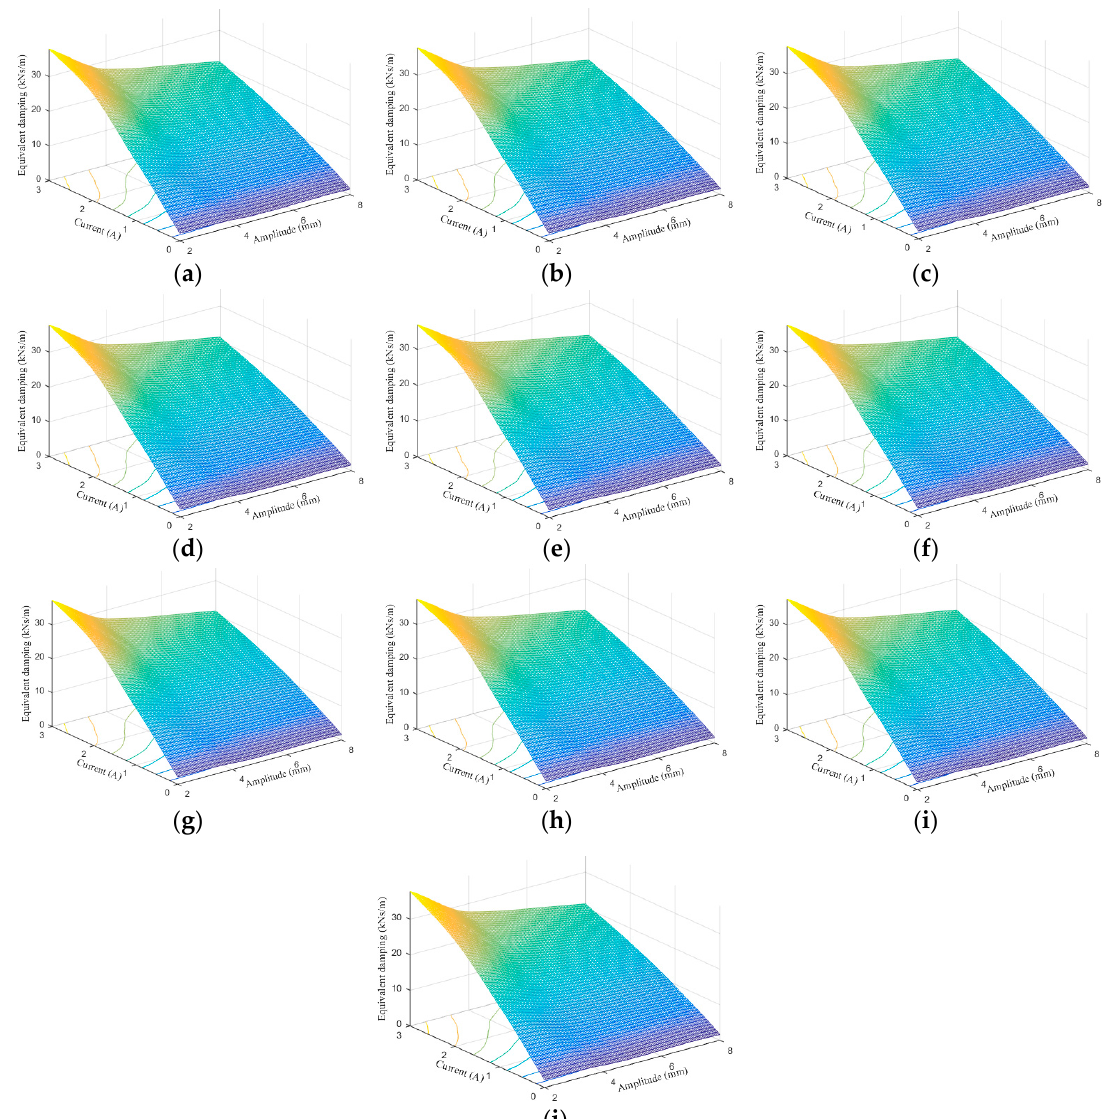
Figure 26. Effective stiffness estimation results of 4 Hz loading frequency. ( a ) Experimental measurement, ( b ) Kelvin–Voigt model, ( c ) four-parameter viscoelastic model, ( d ) rheological model, ( e ) BW model, ( f ) improved BW model, ( g ) Dahl model, ( h ) improved LuGre friction model, ( i ) strain stiffening model, and ( j ) hyperbolic hysteresis model.